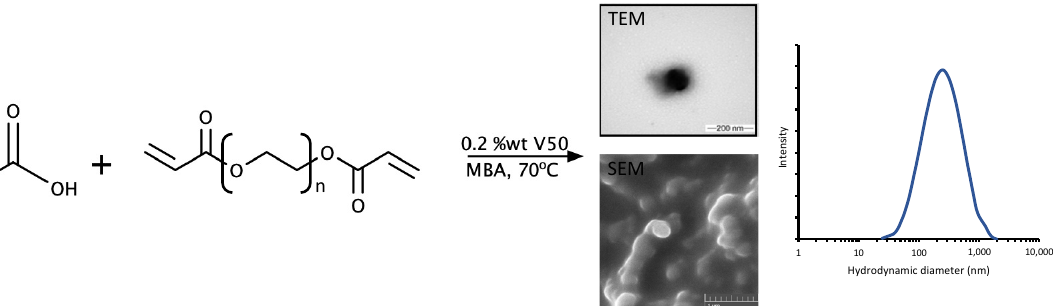
Figure 1. Synthesis of the of PEGDA/AA NPs with resulting NPs observed under TEM and SEM with corresponded particle size.